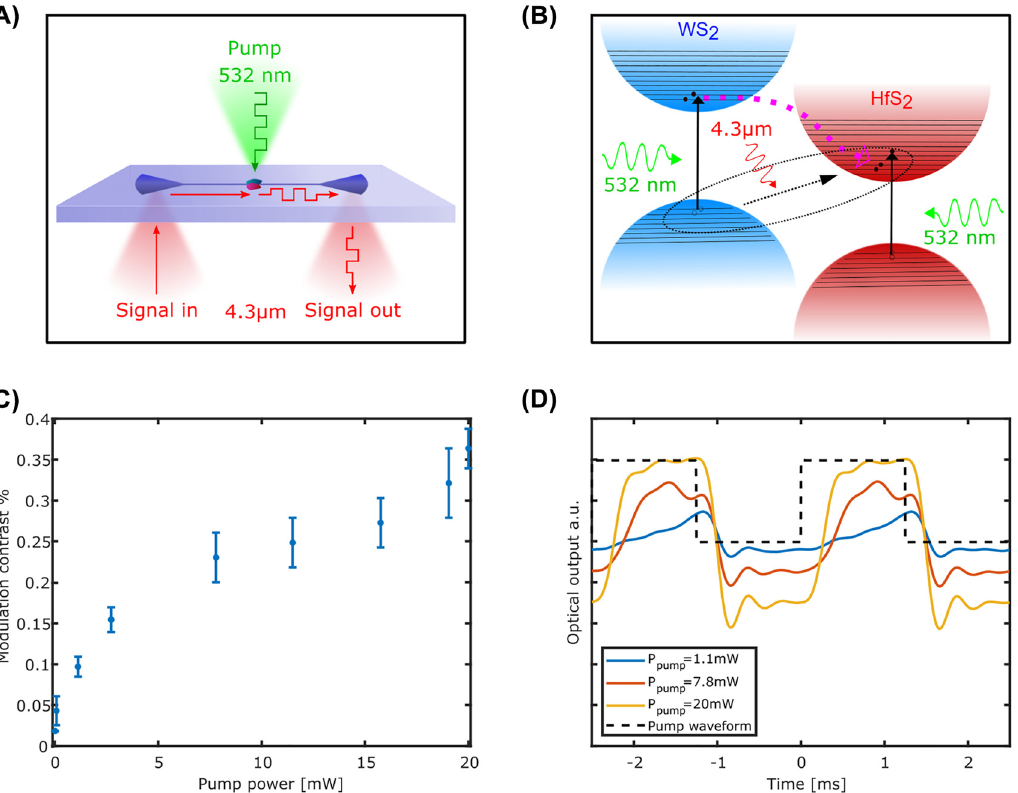
Figure 5: All-optical modulation. (A) All-optical modulation schematics. (B) Energy band diagram for all-optical modulation. (C) Modulation contrast as a function of the pump power. (D) MIR output signal waveforms for different pump powers (only the AC component of the waveform is